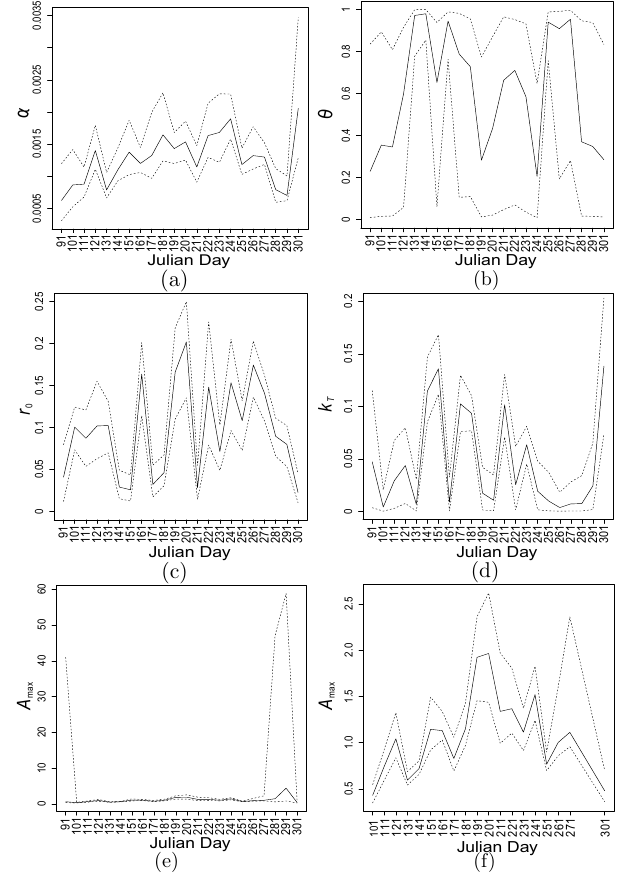
Figure 7. As Fig. 6 when using non-informative prior distributions. To help the visualization of A max we have added a subfigure (f) with the spikes removed (i.e., without the blocks of Julian days 91–100, 281–290, and